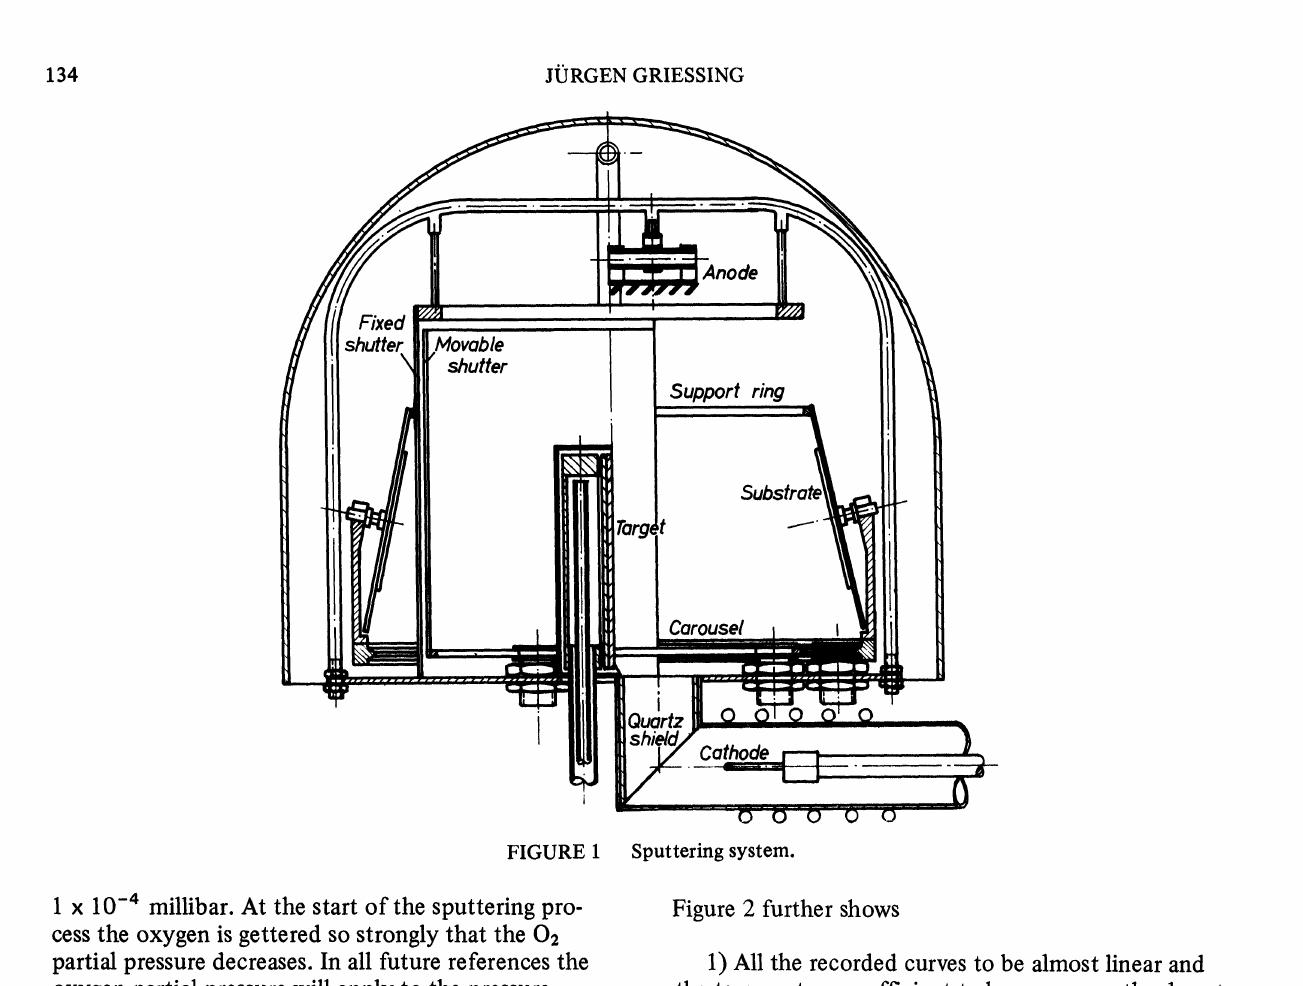
x 10 -4 millibar. At the start of the sputtering pro- cess the oxygen is gettered so strongly that the O2 partial pressure decreases. In all future references the oxygen partial pressure will apply to the pressure before the start of the sputtering cycle. The films were annealed at 3 50C in a circulating-air oven and their temperature coefficient of resistance